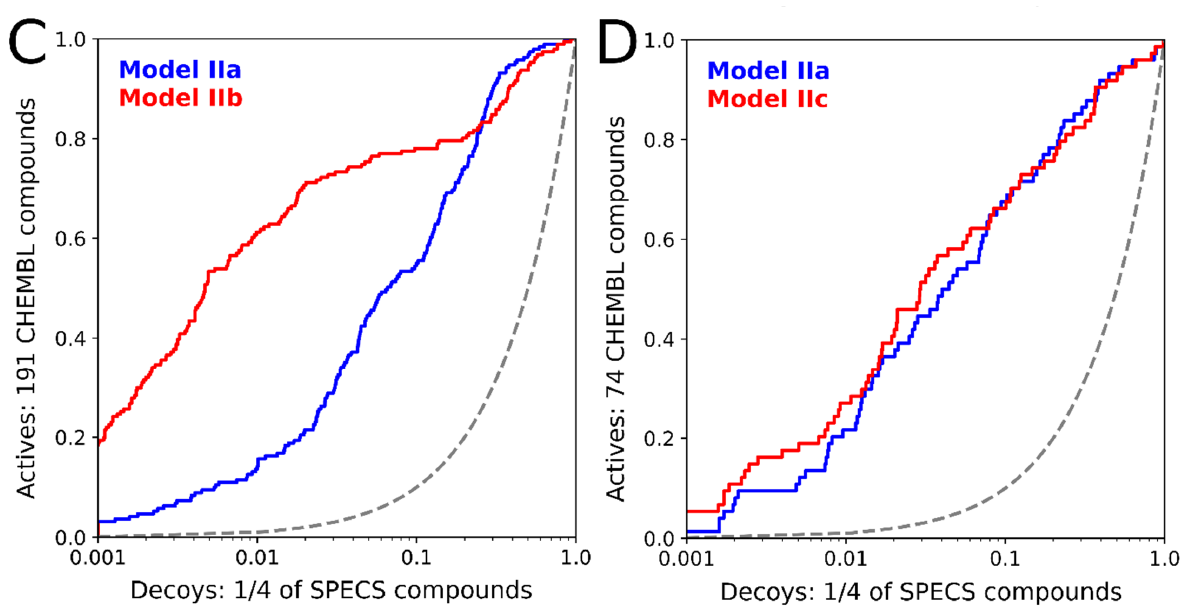
Figure 3. BR-NiB optimization of the original NIB models improved the identification of the active compounds. The semilogarithmic receiver operating characteristics curves show the following enrichments: PDB:5NTW models Ia and Ib with the complete set of active compounds ( A ), PDB:5NTW models Ia and Ic with the lowest-ranked active compounds ( B ), PDB:5VB6 models IIa and IIb with the complete set of active compounds ( C ), and PDB:5VB6 models IIa and IIc with the lowest-ranked active compounds ( D ). The blue graphs present the enrichment of the active compounds based on the original NIB models, while the red graphs present the enrichment based on the BR-NiB-optimized models. True positives are presented in the Y-axis, while false positives are shown in the X-axis [15,47]. The grey dotted line represents random classification of the compounds.